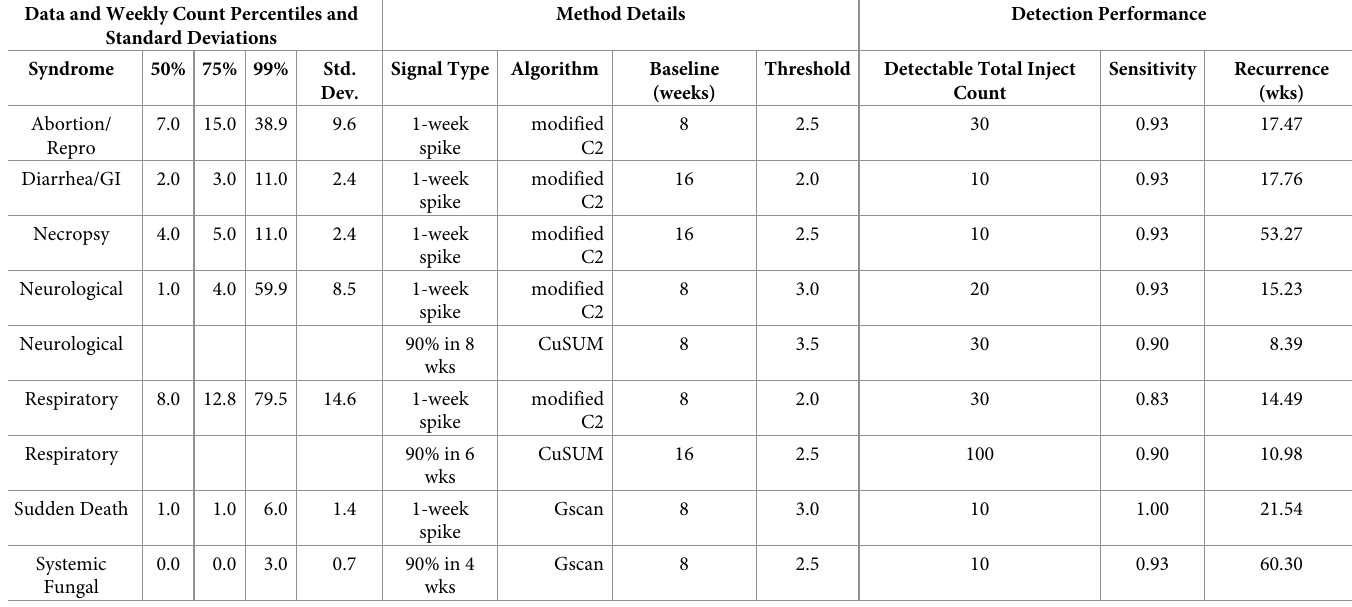
Table 2. ummary of algorithm recommendations for each syndrome and each signal type of concern. Data and Weekly Count Percentiles and Standard